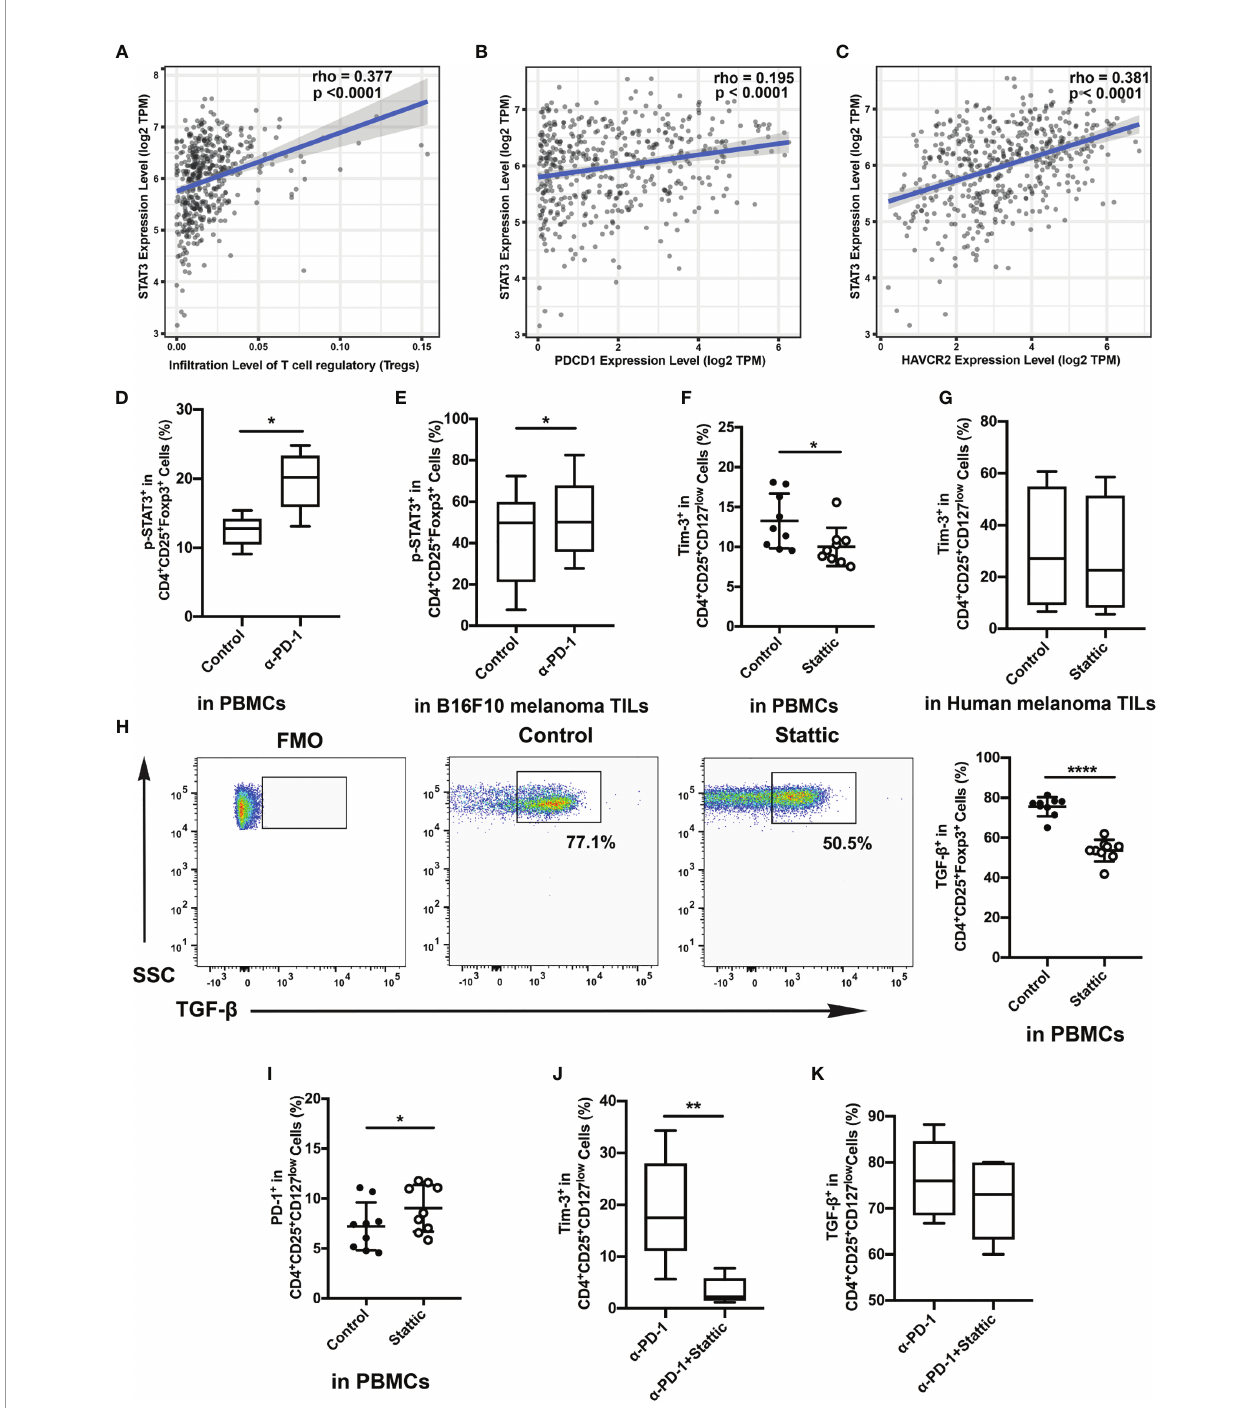
FIGURE 4 | Relationship of STAT3 and Tim-3 in melanoma. (A – C) Correlation between STAT3 expression and tumor-in fi ltrated Treg cells (A) , the expressed genes PDCD1 (B) and HAVCR2 (C) in human melanoma samples from the TCGA dataset. (D, E) p-STAT3 expression after anti-PD-1 treatment both in vitro (D) and in vivo (E) . (F, G) Proportion of circulating Treg cells treated with STAT3 inhibitor compared to that of the control group. Analysis of the phenotypic expression of Tim-3 on Treg cells in PBMCs (F) and human melanoma TILs (G) . (H, I) PD-1 expression (H) and TGF- b (I) production on Treg cells after the STAT3 pathway blockade were also analyzed. Signi fi cance was calculated with a t -test; all data are presented as the means ± SEM, * p < 0.05 and ** p < 0.01. (J, K) Analysis of the expression of Tim-3 (J) and production of TGF- b (K) on puri fi ed Treg cells after anti-PD-1 treatment with Stattic. Signi fi cance was calculated with a t -test; all data are presented as the means ± SEM, * p < 0.05, ** p < 0.01, and **** p ≤